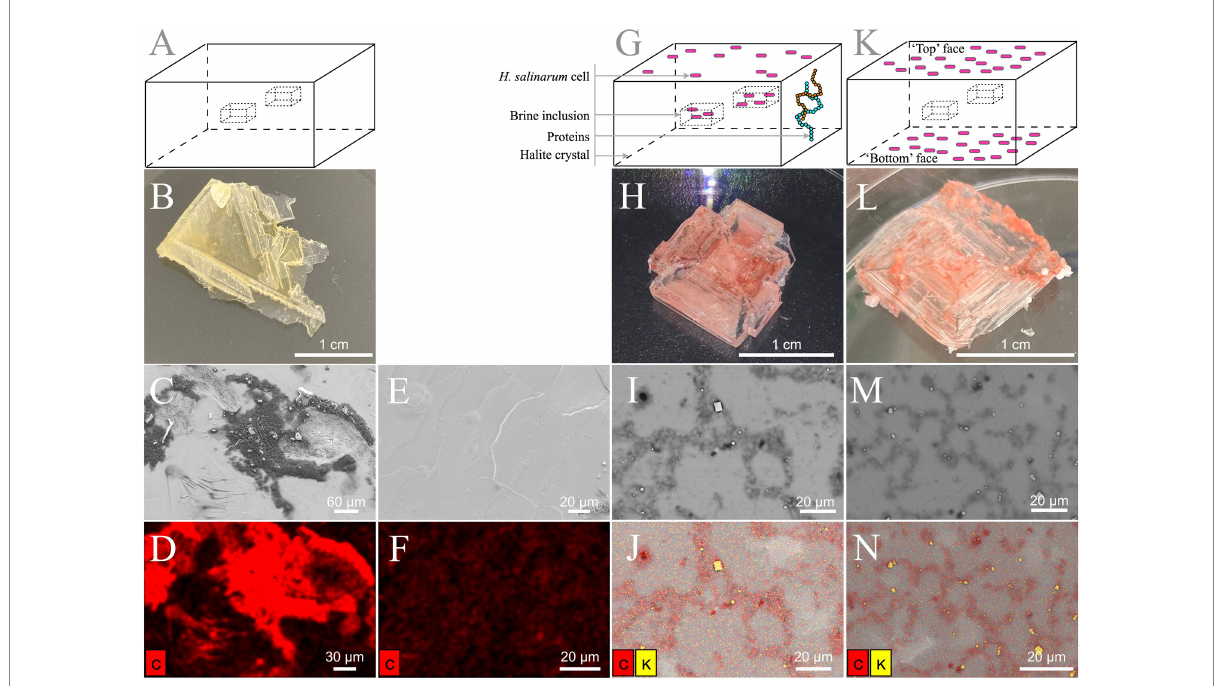
FIGURE 2 Laboratory-grown halite surface observation. ( A–F ) TNPA crystals without cells. ( G–J ) Internally inoculated TNPA crystals with Halobacterium salinarum cells incubated 2 months at 37 ° C. ( K–N ) Externally inoculated TNPA crystals with Halobacterium salinarum cells after ~1 week incubated at 37 ° C. ( A, G, K ) Schematic representation of halite crystals without cells, internally inoculated and externally inoculated, respectively. ( B, H, L ) Visual observation of crystals without cells, internally inoculated and externally inoculated, respectively. ( C, E ) Secondary electron images. ( I, M ) Backscattered images. ( D, F, J, N ) Elemental composition analysis by EDX spectroscopy correlated, respectively, to the SEM images in panels C, E, I, M . Carbon and potassium appear in red and yellow,